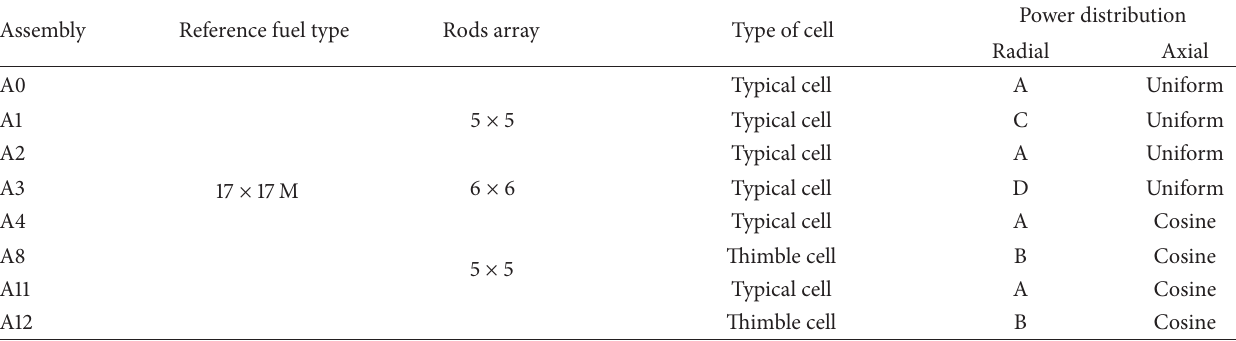
Table 6: Test assemblies for DNB measurements.